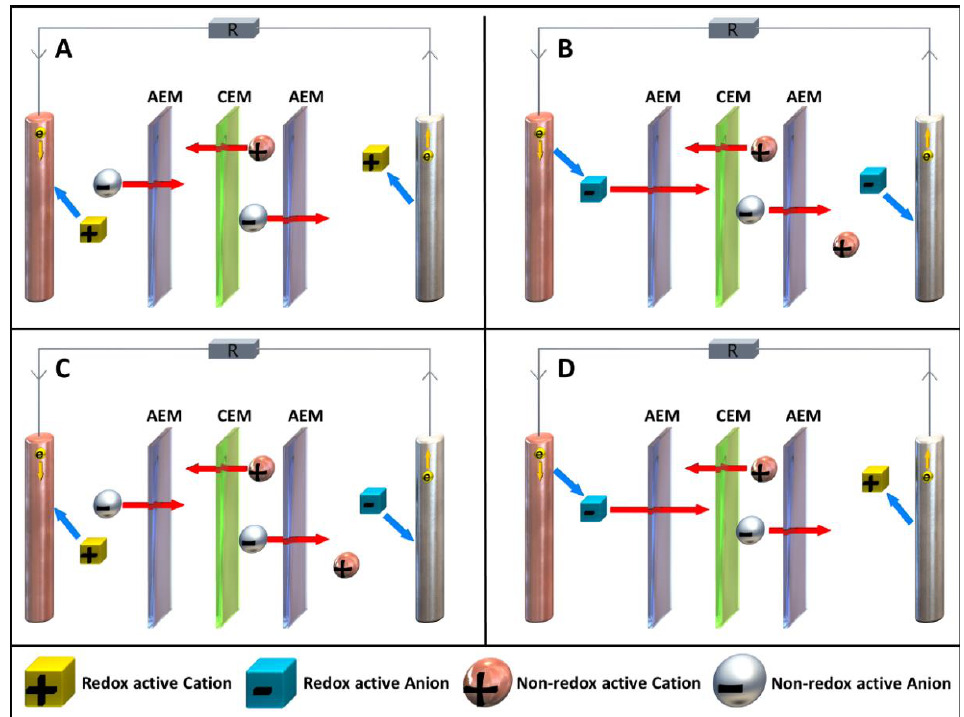
Figure 6. Overview of all possible redox pair combinations, exemplified by the triple membrane configuration AEM/CEM/AEM, during the discharge process (anolyte on the right and catholyte on the left, respectively). The redox active ions are shown as cubes and non-redox active ions as spheres. ( A ): the RAS are positively charged in the anolyte and in the catholyte; ( B ): the RAS are negatively charged in the anolyte and in the catholyte; ( C ): the RAS within the anolyte is positively charged and that within the catholyte, negatively charged; ( D ): the RAS within the anolyte is negatively charged and within the catholyte, positively